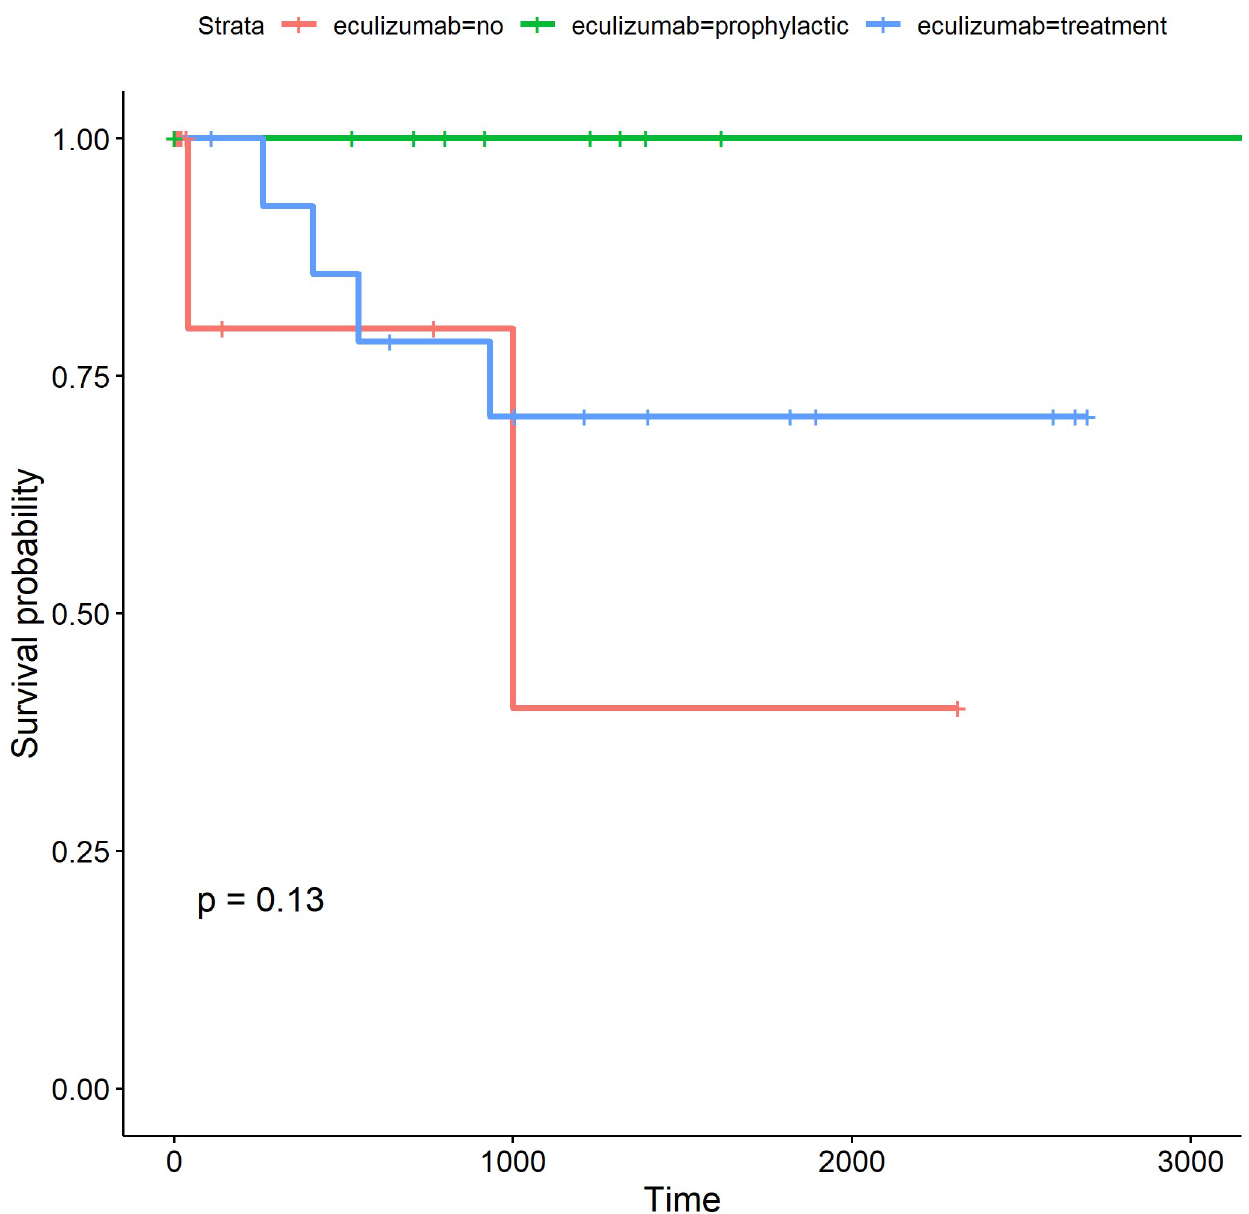
Fig 3. Cumulative survival (days) in the Brazilian aHUS cohort patients divided by groups: Not received eculizumab (red), prophylactic eculizumab (green), and eculizumab treatment (blue).